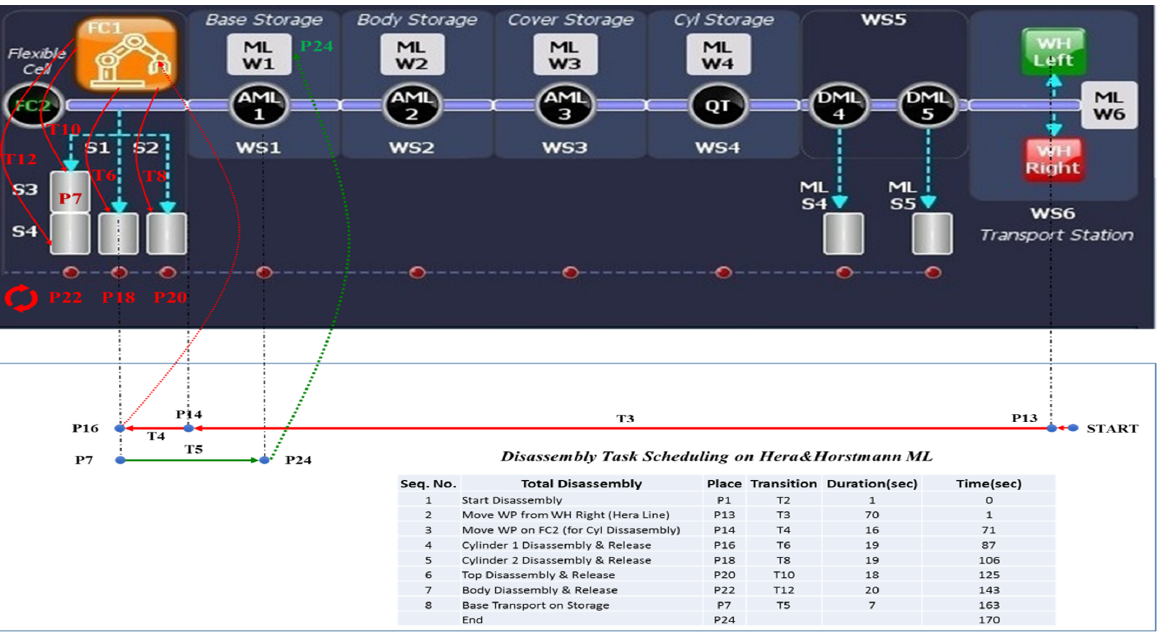
Figure 13. Task scheduling for disassembly operation on Hera&Horstmann ML.